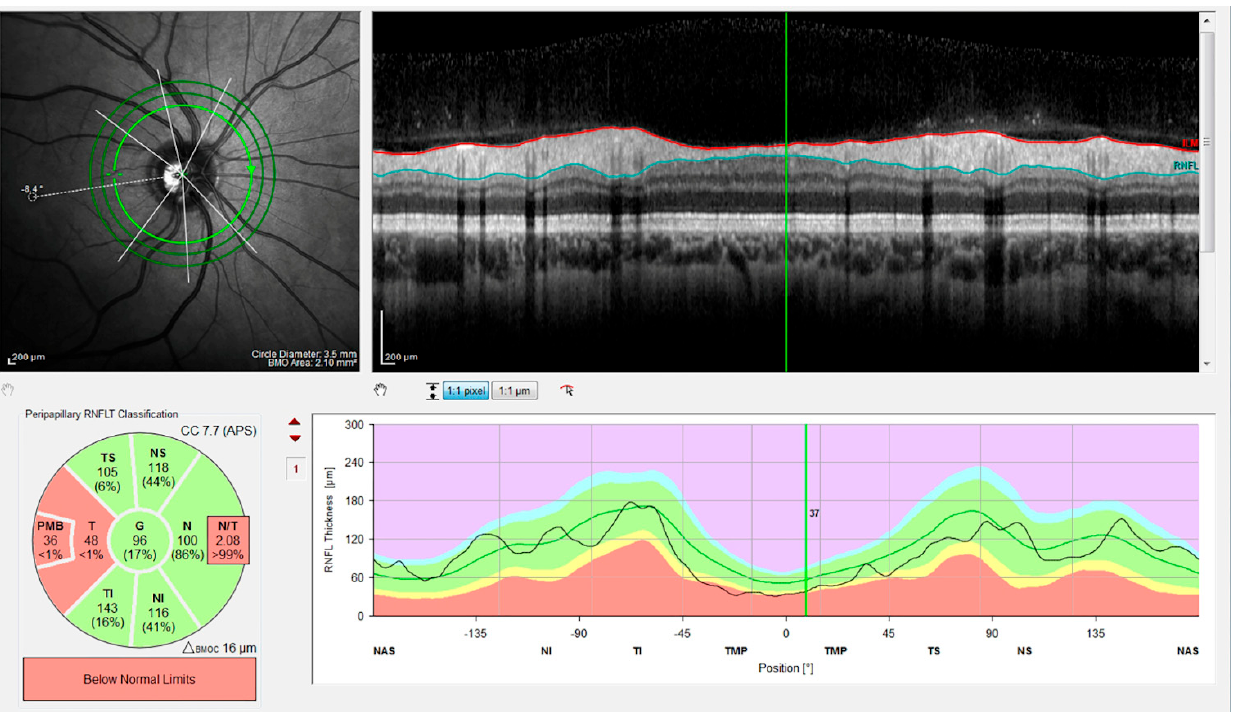
Figure 2. OCT scan of the optic nerve in a patient affected by MS.